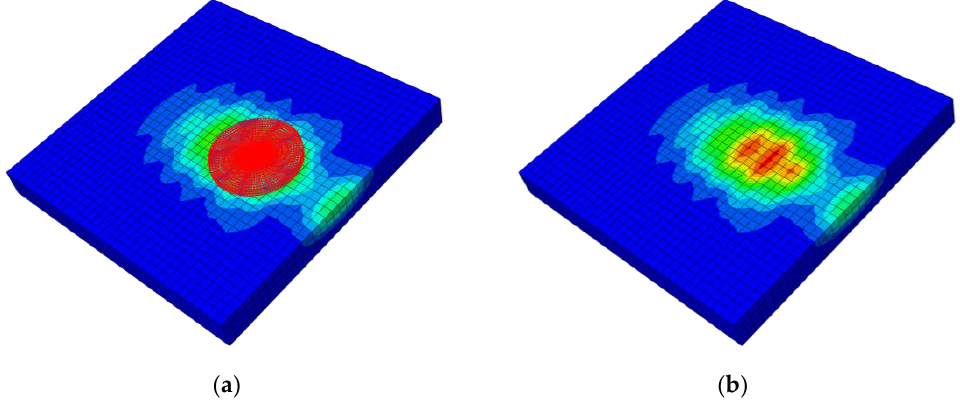
Figure 11. Deformation of the sliding plate (only +direction, 10 kN vertically loaded): ( a ) distribution on the sliding plate at 30 mm (with the ceramic friction material); ( b ) distribution on the sliding plate at 30 mm (without the ceramic friction material).